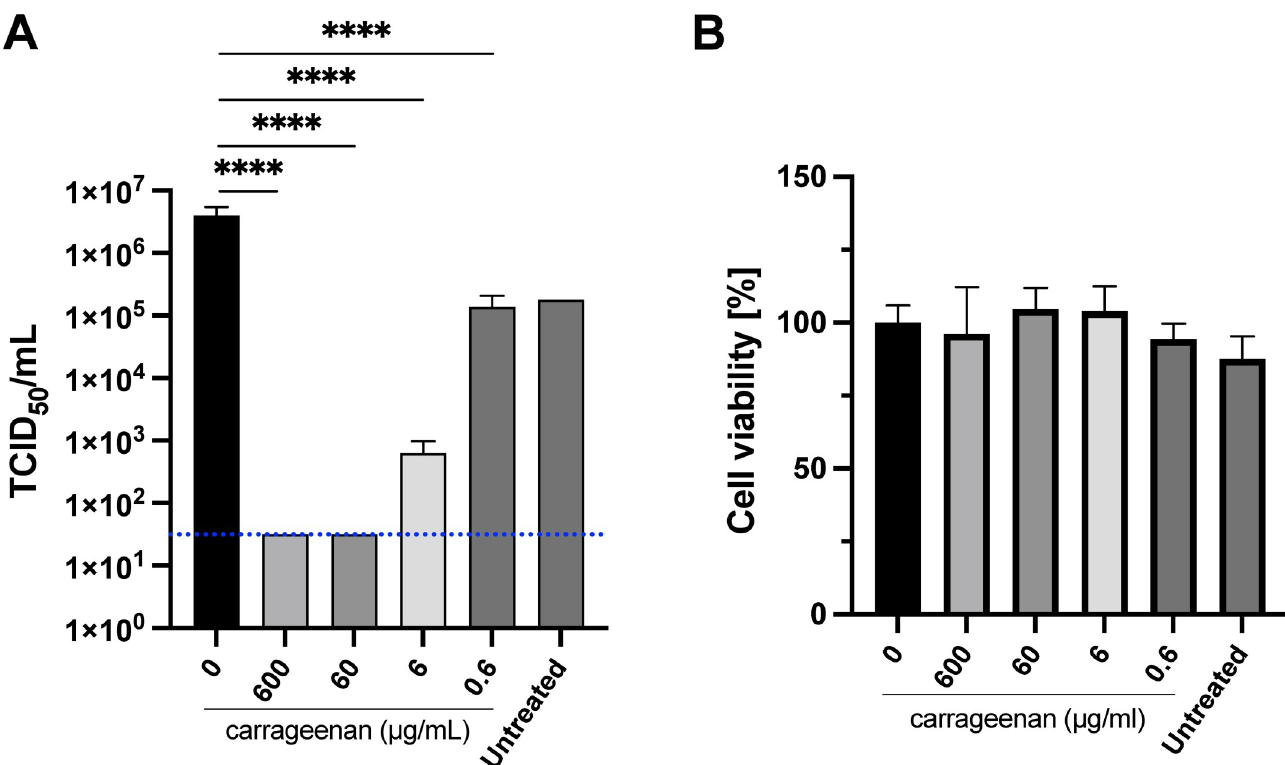
Fig 1. SARS-CoV-2 viral titer after treatment with Samples 1 and P1. A) Infection assay. Sample 1 composition: 1.2mg/mL iota-carrageenan, 9 mg/mL sodium chloride, pH 6–7. Vero E6 were pre-treated for two hours with dilutions of Sample 1 with Sample P1 (diluent without iota-carrageenan) to obtain 600 μ g/mL, 60 μ g/mL, 6 μ g/mL, and 0.6 μ g/mL iota-carrageenan final concentration. After this pretreatment, cells were infected with SARS-CoV-2 and incubated for 48 hours in the presence of the same dilutions of Sample 1. Supernatants were harvested and virus yield was determined using an end point dilution assay (TCID 50 ). Controls consisted of untreated infected cells or infected cells treated with P1 (no iota-carrageenan). Results were determined using the Reed and Muench formula and expressed as log TCID 50 /mL. The dotted line shows the limit of detection (LOD). Testing of samples was performed in triplicate, and the p-values are p � 0.00025 ( ���� ). B) Cellular viability assays. Vero-E6 cells were treated with iota-carrageenan or vehicle (600 μ g/mL to 0 μ g/mL) for 48 h at 37˚C. After incubation, cellular viability was analyzed, and no statistically significant difference was found between the groups compared to the untreated control group (Group 600 μ g/ml, p = 0.7464, Group 60 μ g/ml, p = 0.0908, Group 6 μ g/ml, p = 0.1208, and Group 0.6 μ g/ml, p = 0.8938). Data are expressed as mean ± SD. Therefore, these compositions do not adversely affect cell viability. For this reason, cell lysis and death detected in the reported experiments after infection must be attributed to the action of the virus.